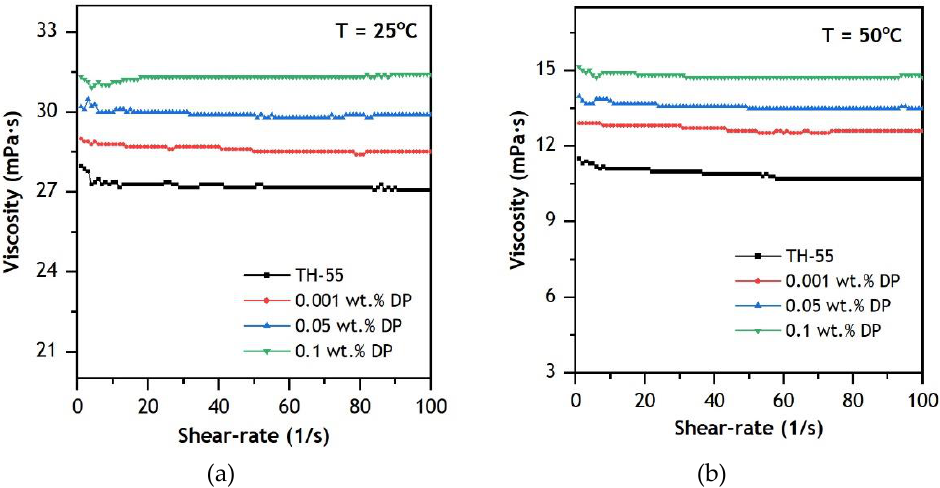
Figure 9. Rheological behavior of TH-55/DP nanofluids at 0 – 100 s −1 shear rate: ( a ) 25 °C and ( b ) 50 °C.